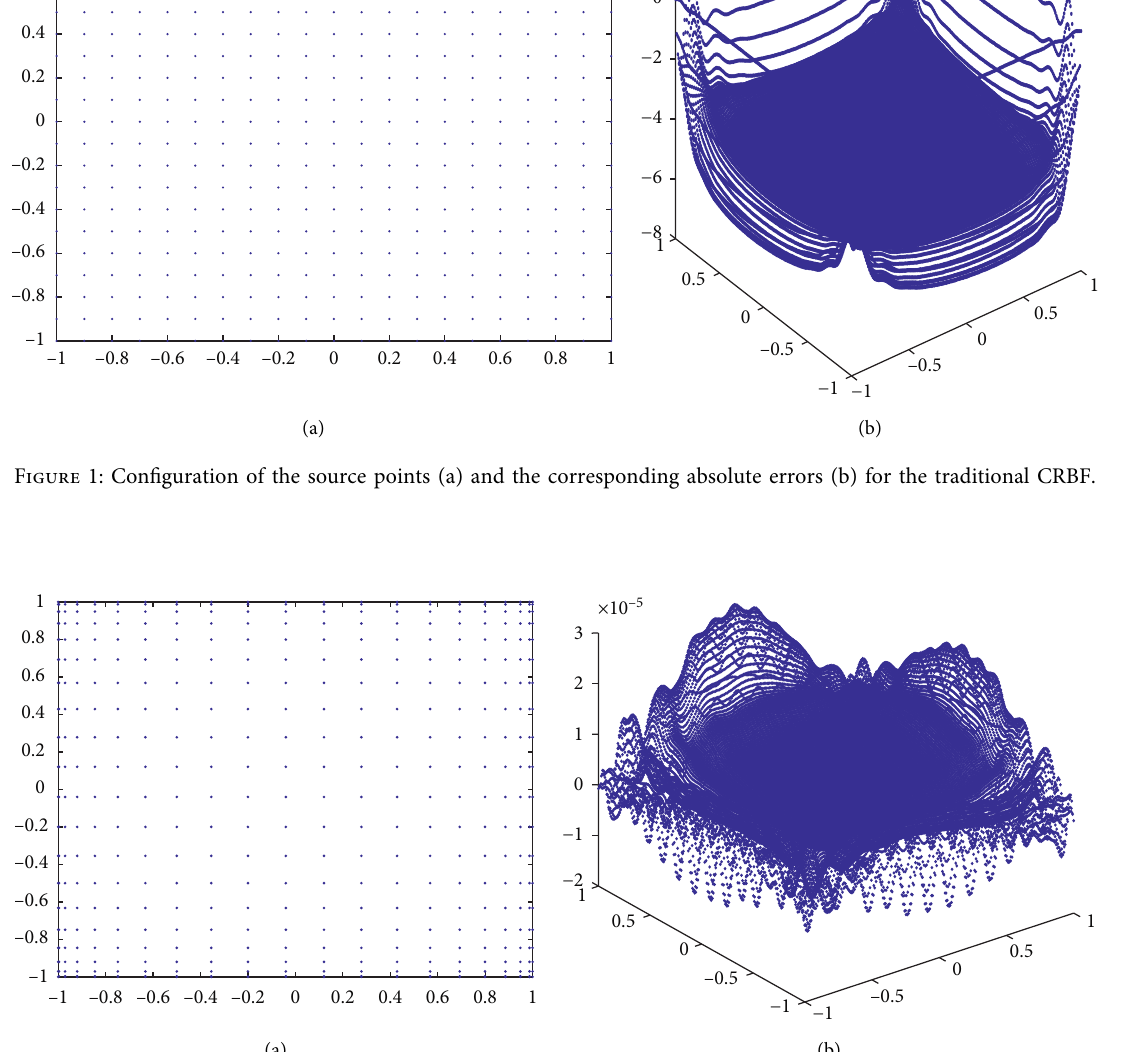
–1 –0.8 –0.6 –0.4 –0.2